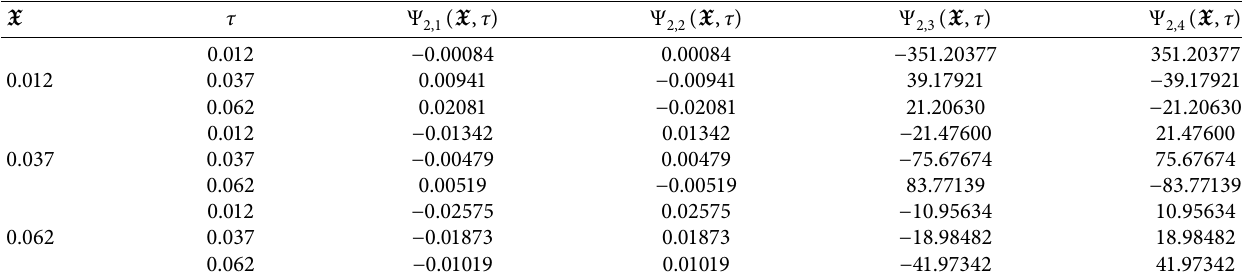
Table 3: The real part of exact solutions of CTFMNLSE (1) obtained by the MTEM with several point sources through arbitrary. X